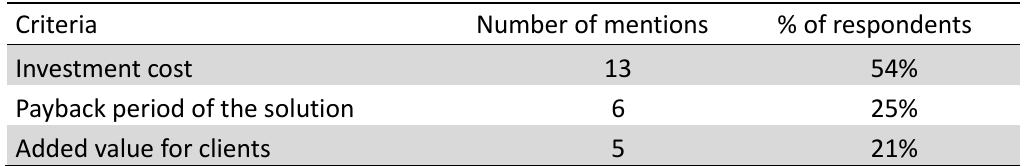
Table 2: Criteria for evaluation of sustainable solutions which are considered the most important by the respondents (source: